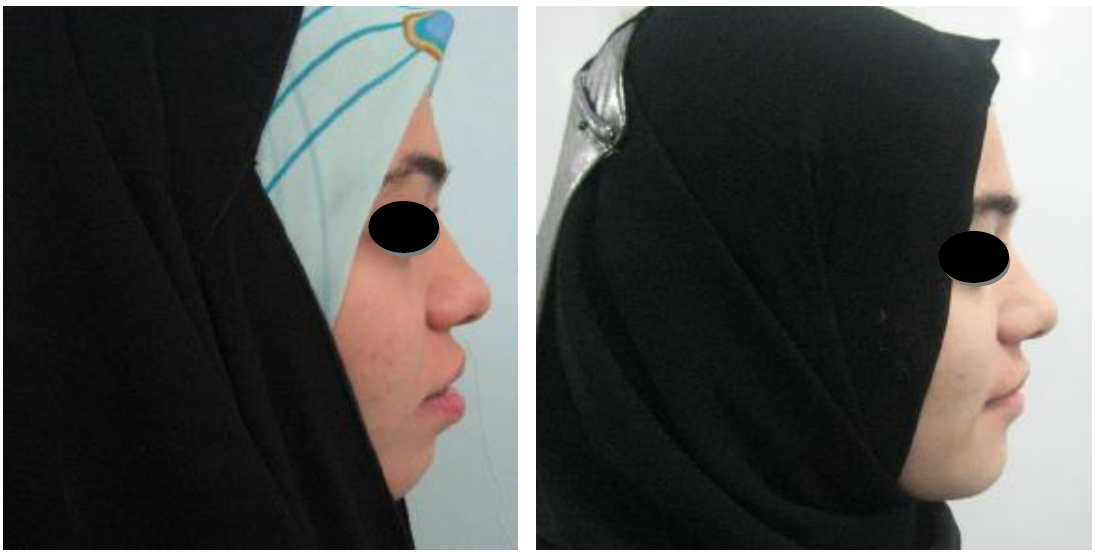
Figure 1: Case Pre and Post